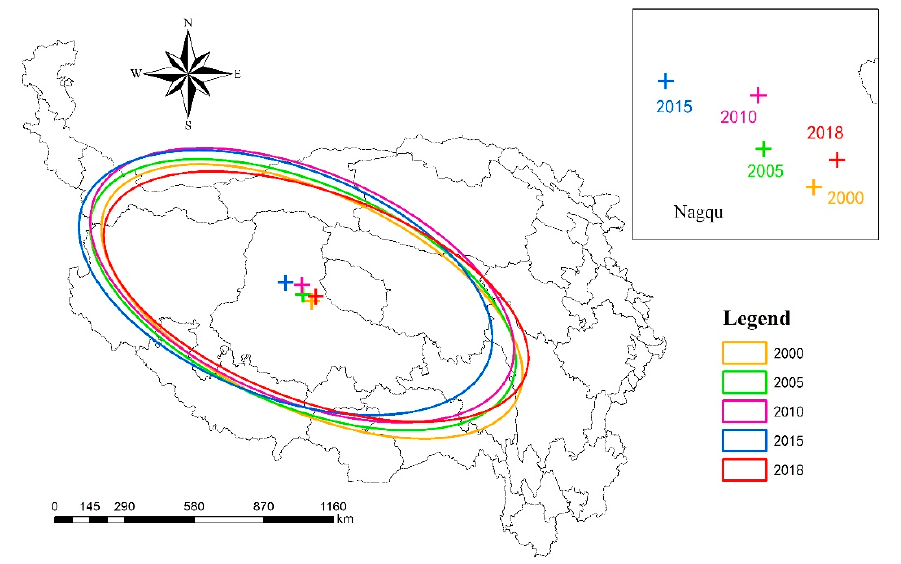
Figure 4. The standard deviation ellipse and its gravity center of the spatially distributed remote sensing ecological vulnerability index on the Qinghai-Tibet Plateau from 2000 to 2018. Table 3. Standard deviation ellipse parameters of the remote sensing ecological vulnerability index on the Qinghai-Tibet